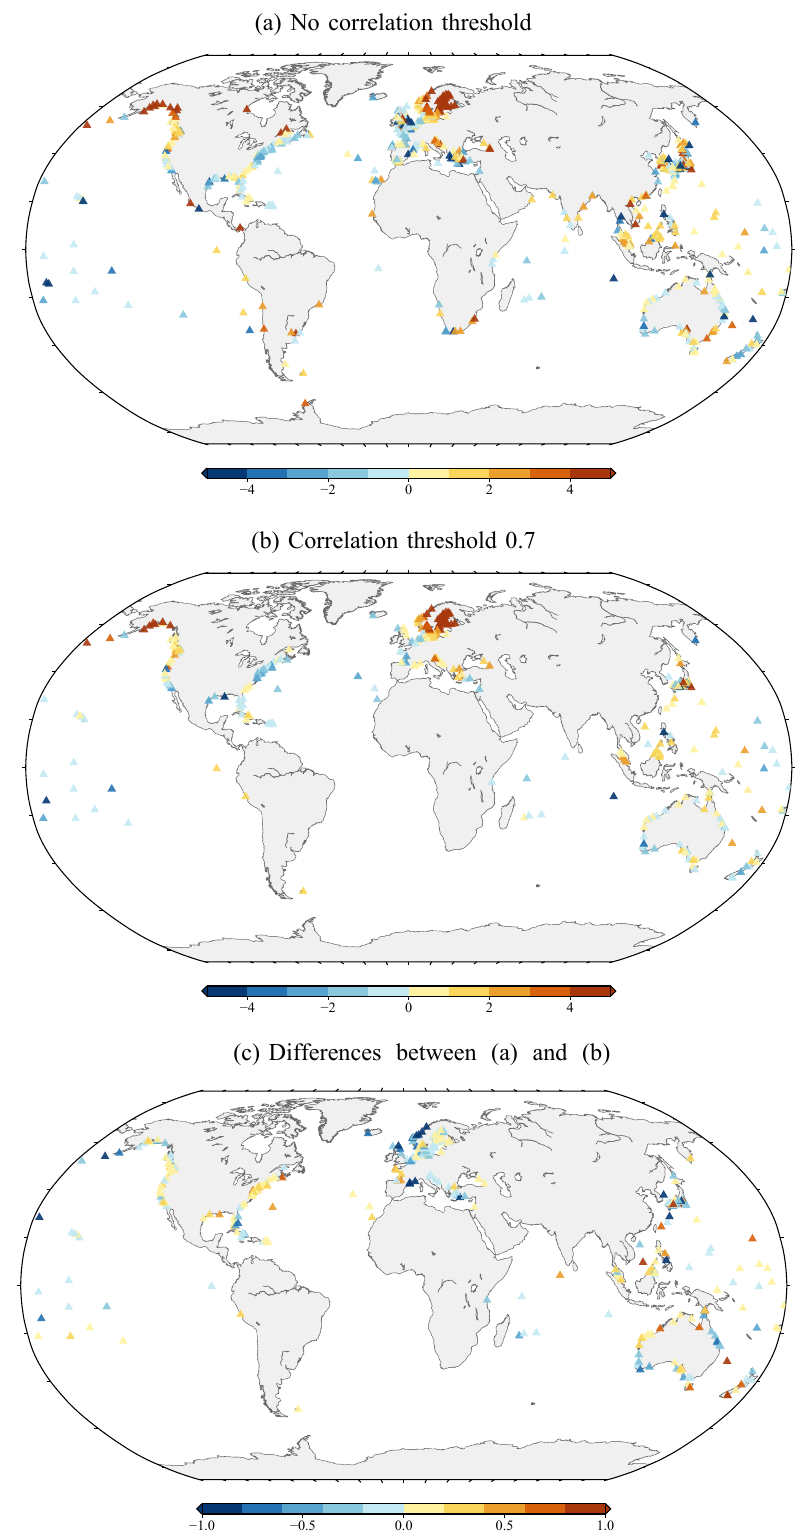
Figure 6. ALT–TG trends (mm yr − 1 ) estimated using no threshold (a) , with a correlation threshold and correlation weighting (b) and the difference between them (c)